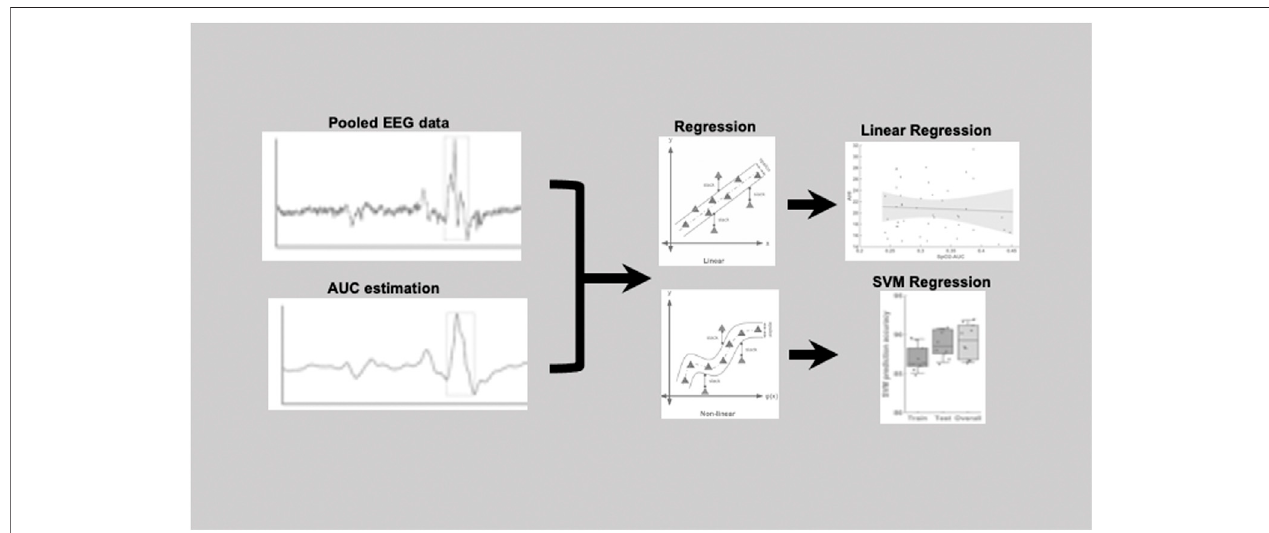
Frontiers in Physiology |